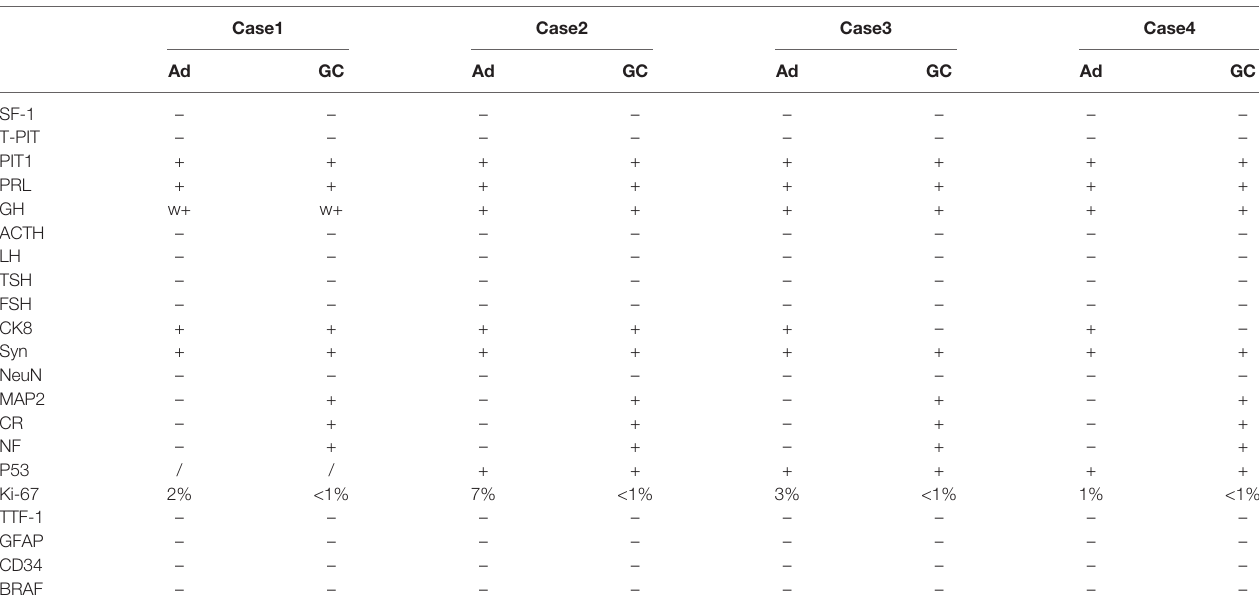
TABLE 2 | List of immunohistochemical results.